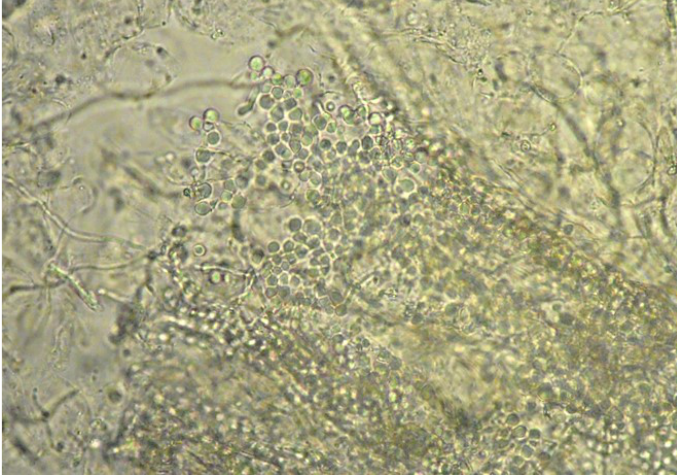
Figure 4. Direct examination of a skin scraping: hair invaded by fungal structures (arthroconìdia) (40× magnification).